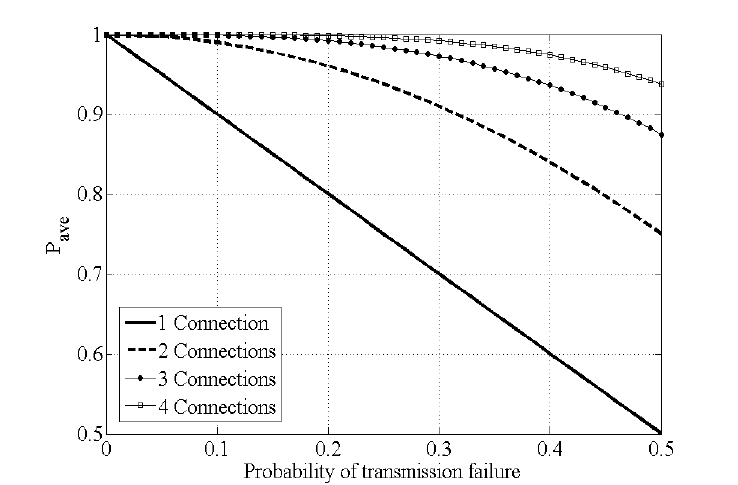
Figure 3. Successful transmission probability